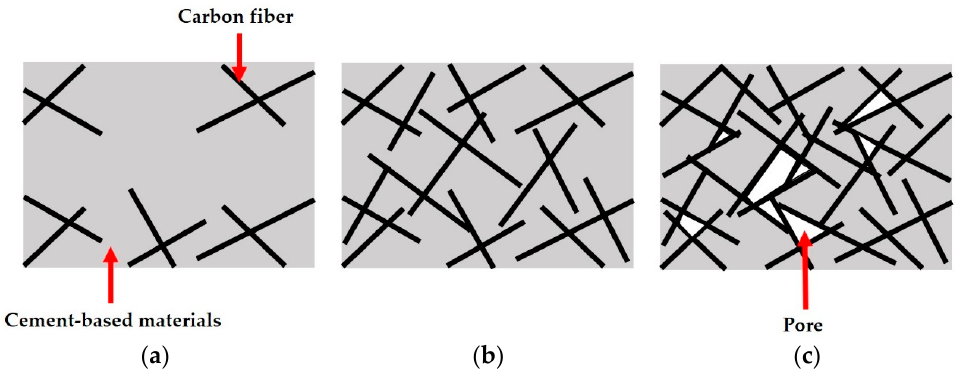
Figure 12. Illustrations of fiber distribution in the concrete specimens. ( a ) Low fiber content ; ( b ) optimal fiber content ; ( c ) high fiber content .